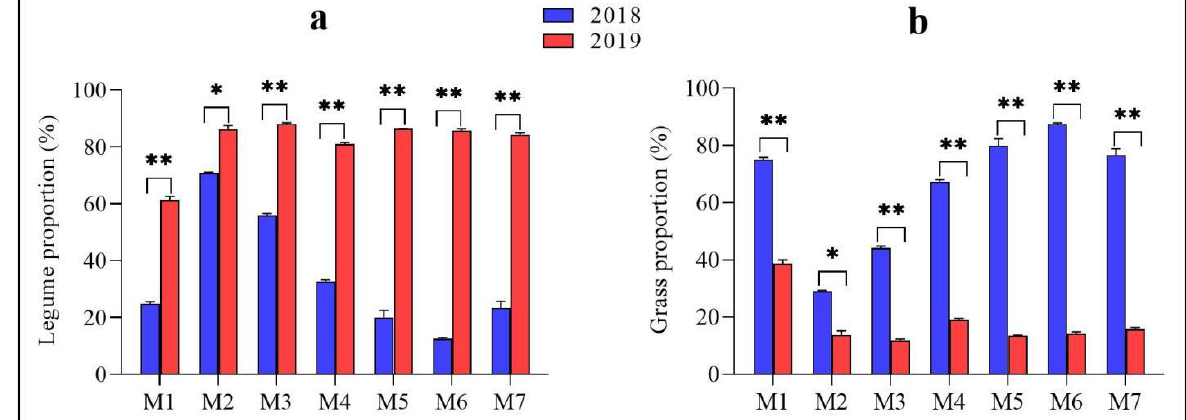
Figure 1. The biomass yield proportions of the same type of components in legume–grass mixtures within different years: ( a ) for legume and ( b ) for grass. M1: WC + O + TF; M2: A + O + TF; M3: A + WC + O + TF; M4: RC + WC + O + TF; M5: A + WC + O + TF + PR; M6: RC + WC + O + TF + PR; and M7: A + RC + WC + O + TF + PR. A, alfalfa; WC, white clover; RC, red clover; O, orchardgrass; TF, tall fescue; and PR, perennial ryegrass. Error bar shows the standard error mean of the replicates. Significance was tested by Student’s t-test. ‘*’, ‘**’ shows the significant differences at p < 0.05 and p < 0.01.